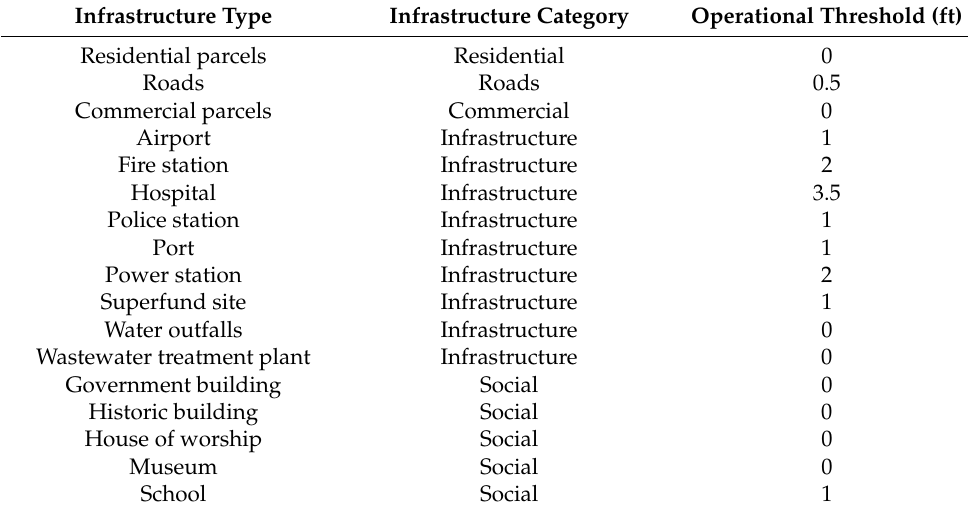
Table 2. Operational thresholds